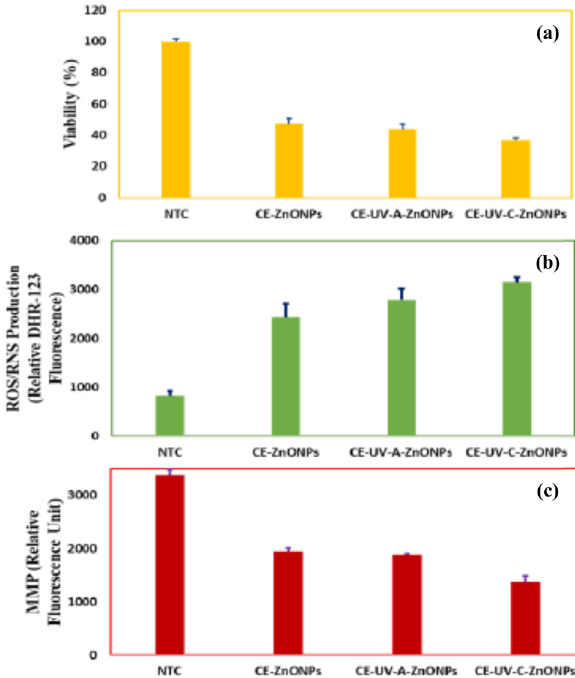
Figure 12: ZnONPs have anticancer properties: ( a ) HepG2 cell sur - vival measurement, ( b ) ROS/RNS production measurement, and ( c ) HepG2 mitochondrial membrane potential measurement in response to green - synthesized - ZnONP therapy [ 5 ] . Copyright Figure 13: A possible antibacterial mechanism for NiO nanoparticles [ 62 ] . Copyright © 2020;